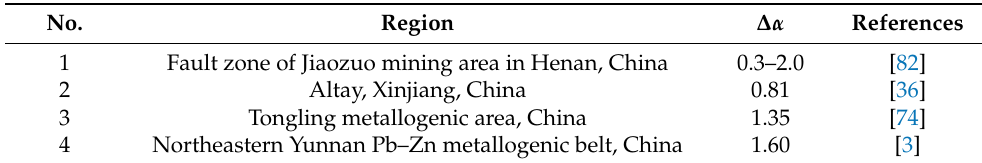
Table 3. Multifractal width with different